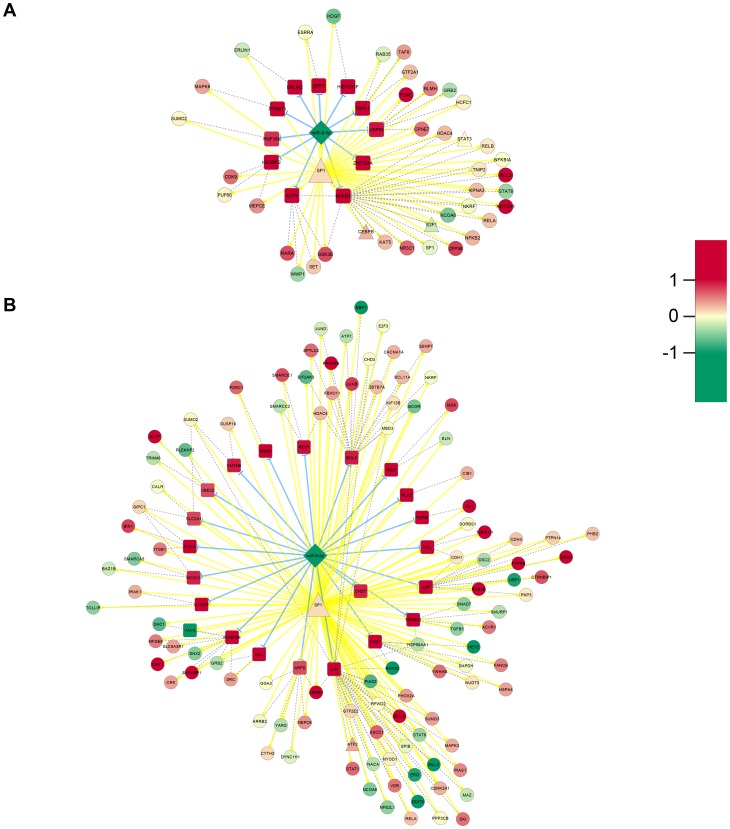

miR-9-5p and SP1 co-regulatory motifs.The co-regulatory motifs of miR-9-5p and SP1 are illustrated as graphs with nodes and edges for (A) C1 and (B) C2. MicroRNAs are marked with diamonds, TFs with triangles, primary targets with rectangle, and secondary targets with a circle. Yellow edges tag protein-DNA interactions, blue edges microRNA-target interactions, and dashed edges protein interactions. The red/green color code presents the corresponding log2 FC.